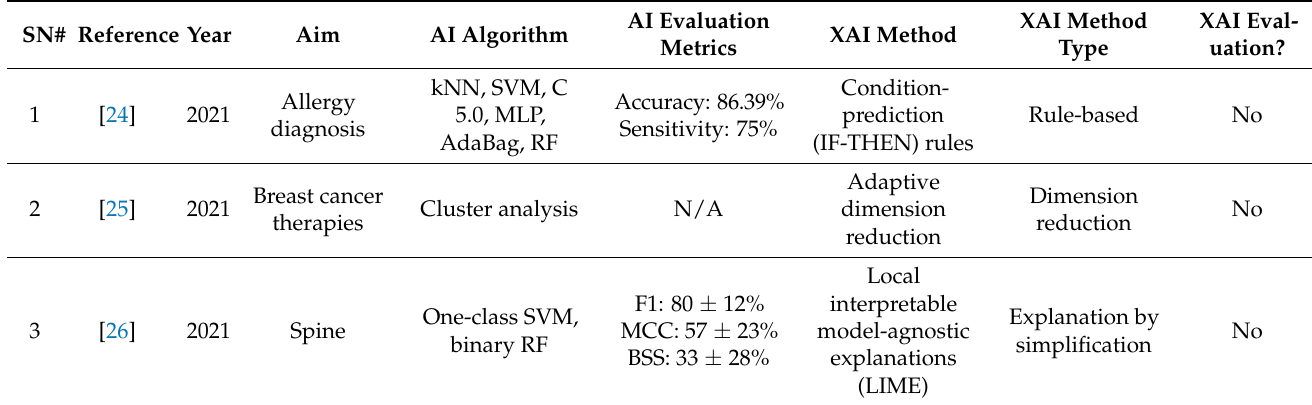
Table 1. Literature review of medical XAI applications in